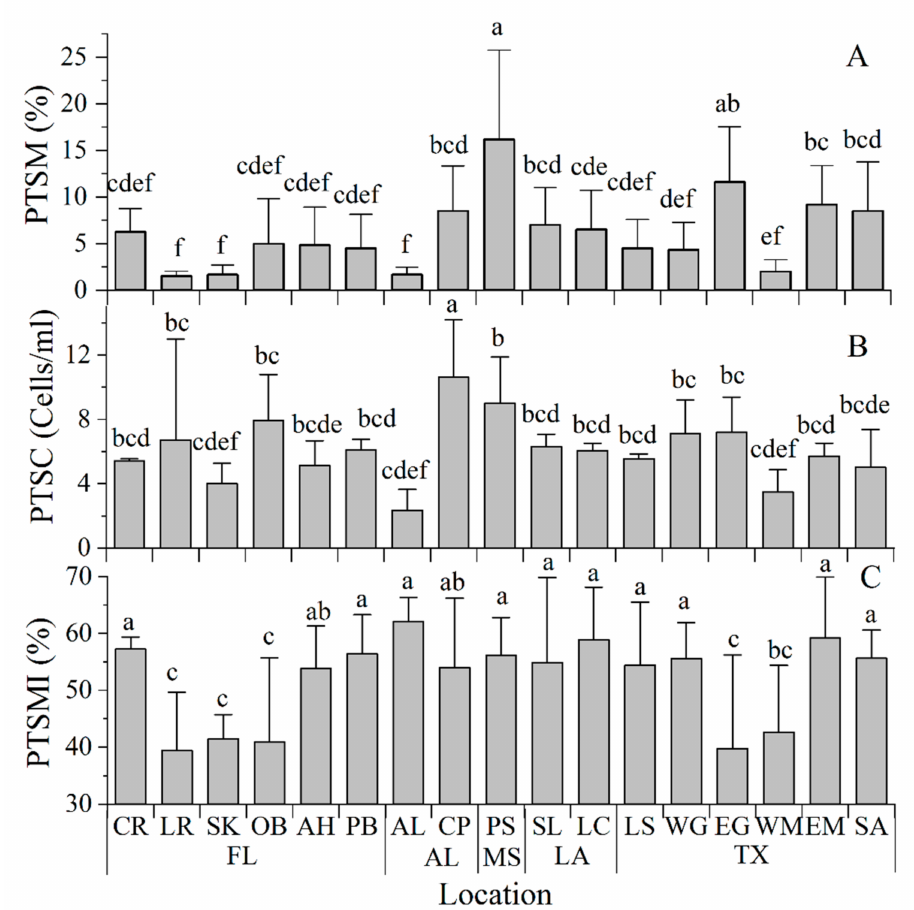
Figure 6. Post-thaw sperm quality analyses in Eastern oysters Crassostrea virginica from 17 collection sites along the Gulf of Mexico. ( A ). Post-thaw sperm motility (PTSM, %); ( B ). Post-thaw sperm concentration (PTSC, cells/mL), and ( C ). Post-thaw sperm membrane integrity (PTSMI, %). Groups labeled with the same letters (a–f) are not statistically different ( p >